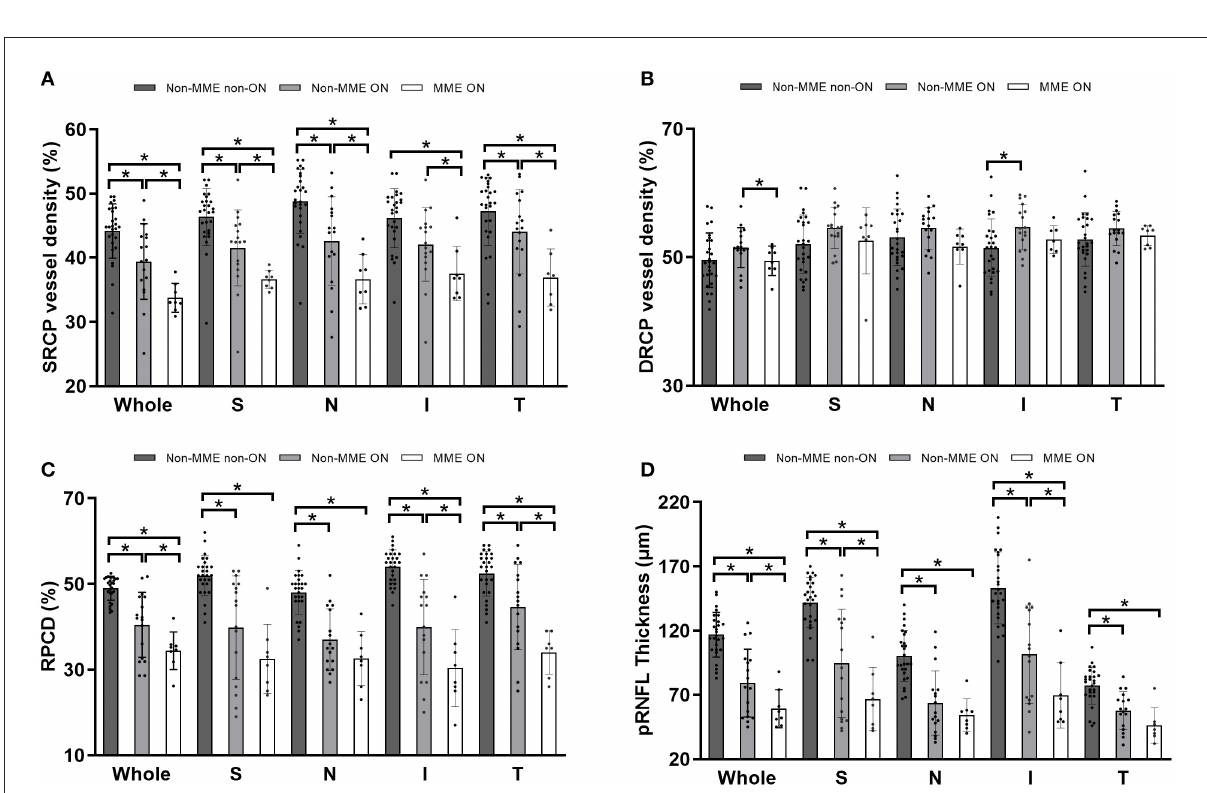
FIGURE4 (A,B) Comparison of superficial retinal capillary plexus (SRCP) and deep retinal capillary plexus (DRCP) vessel density among groups of non-MME non-ON, non-MME ON, and MME ON eyes. The vessel density in SRCP is significantly lower in eyes with MME ON than in eyes with non-MME ON and non-MME non-ON in the whole macular image and in all grid sections. The vessel density in DRCP is also similar among the three groups. (C,D) Comparison of radial peripapillary capillary density (RPCD) and peripapillary retinal nerve fiber layer (pRNFL) thickness among three groups. * P < 0.05. SRCP, superficial retinal capillary plexus; DRCP, deep retinal capillary plexus; RPCD, radial peripapillary capillary density; pRNFL, peripapillary retinal nerve fiber layer; MME, microcystic macular edema; ON, optic neuritis; S, superior; N, nasal; I, inferior; T,